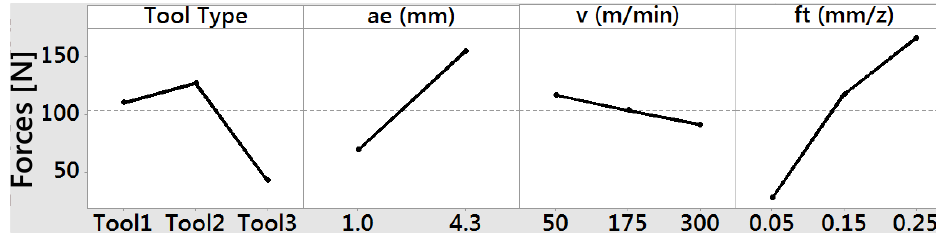
Figure 17. Main effect plot for cutting forces.